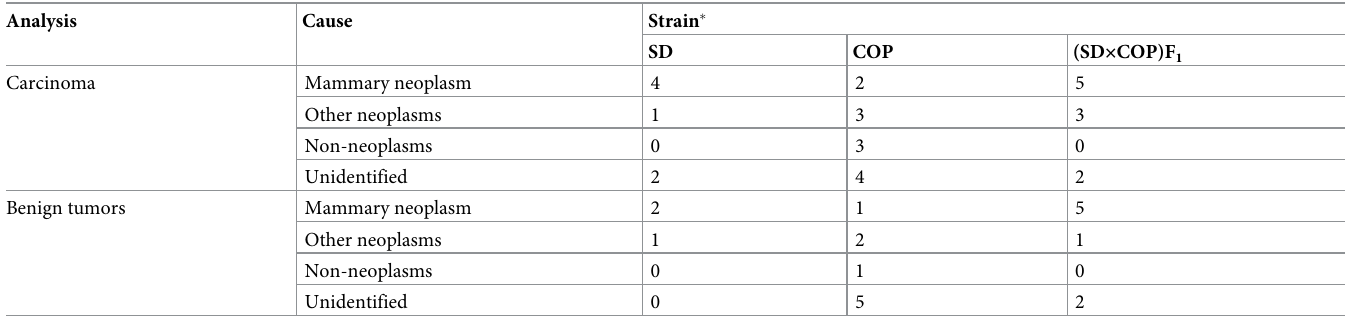
Table 5. Causes of